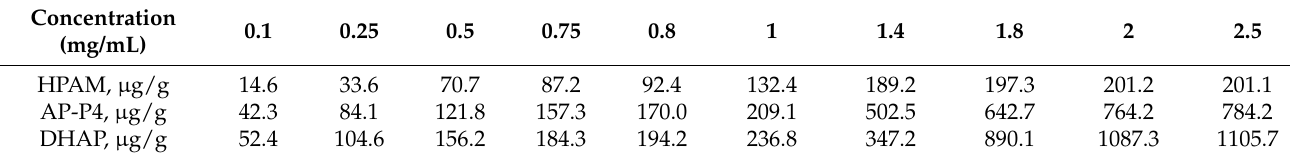
Table 3. Static adsorption capacity at various